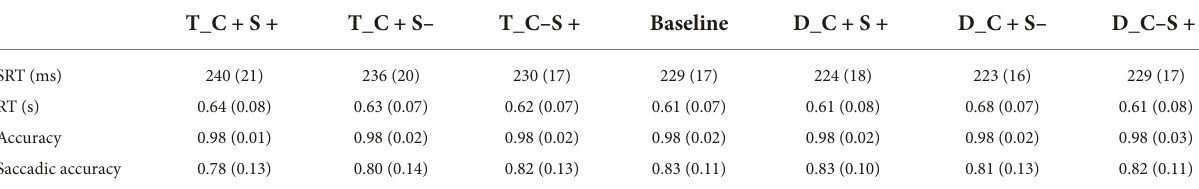
TABLE 3 Mean saccadic reaction time (ms) and reaction time (s) and accuracy and saccadic accuracy for all condition of Exp. 2 (standard deviations are within